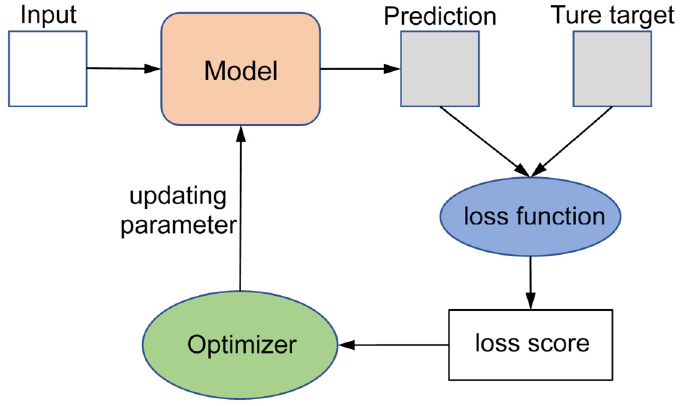
Figure 2. Schematic showing the core components of the machine learning model and the training process.